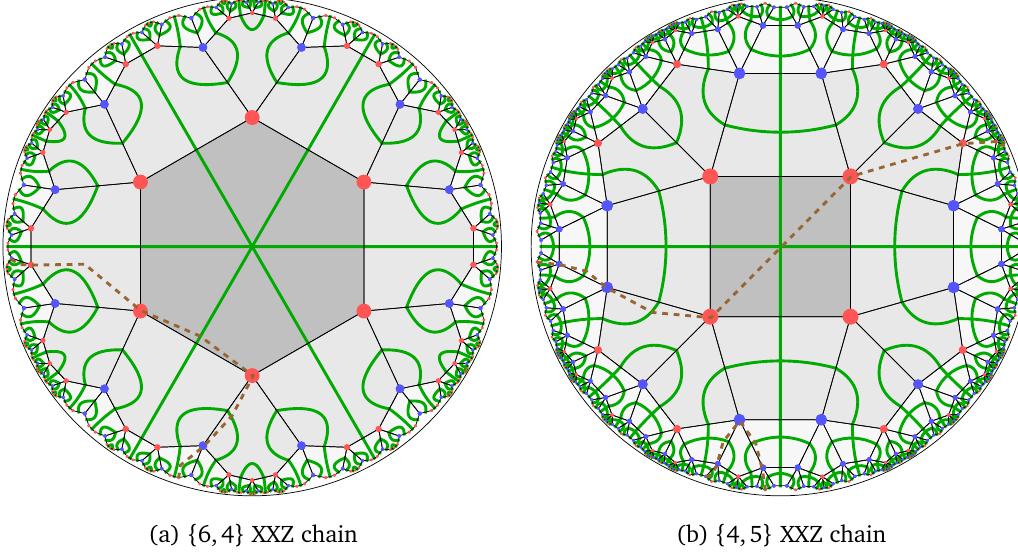
Figure 11: Tensor networks of the ground states of an aperiodic { p , q } XXX chain on a circle. The TNs are depicted by green lines and fit the tiling commensurately. The weak and strong bonds in Fig. 10 at each step of the RG flow are denoted by red and blue dots, respectively. a) TN of the { 6,4 } XXX chain, consisting of identical rank-2 tensors (excluding the central tensor). b) TN of the { 4,5 } XXX chain, consisting of identical rank-4 tensors and rank-2 tensors. Various minimal cuts, homologous to the corresponding subregions on the boundary, are shown with brown dashed